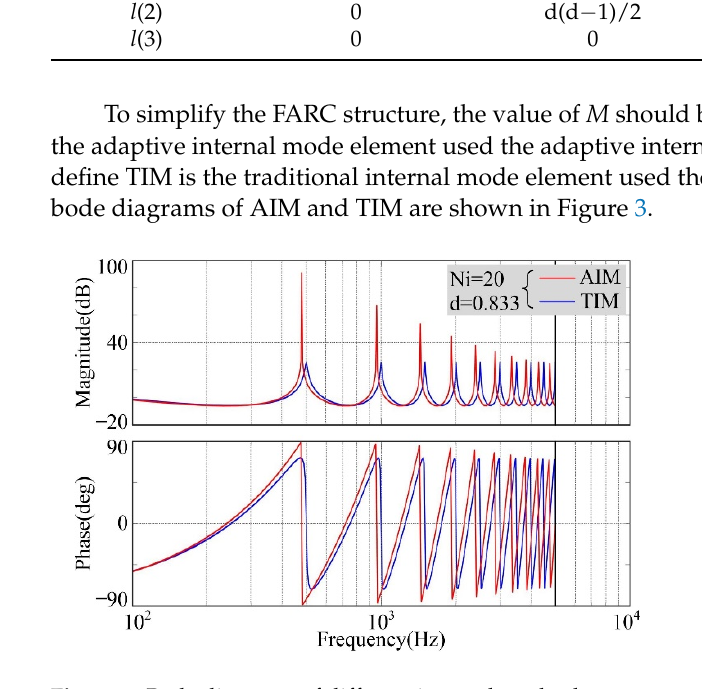
Figure 3. Bode diagrams of different internal mode elements.